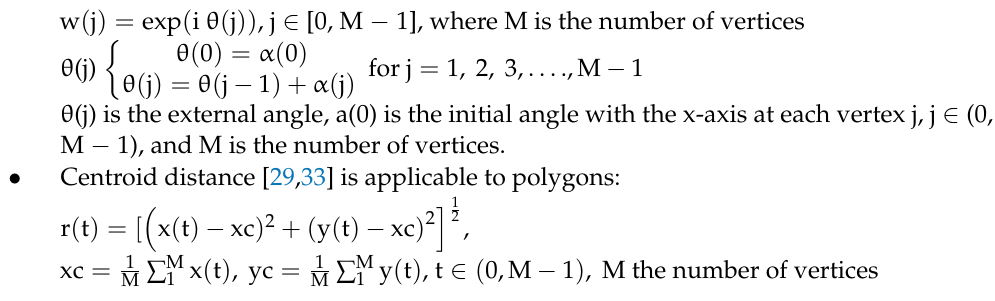
Figure 3. Angles in the complex-valued exponential function of the total curvature (redrawn) [32].